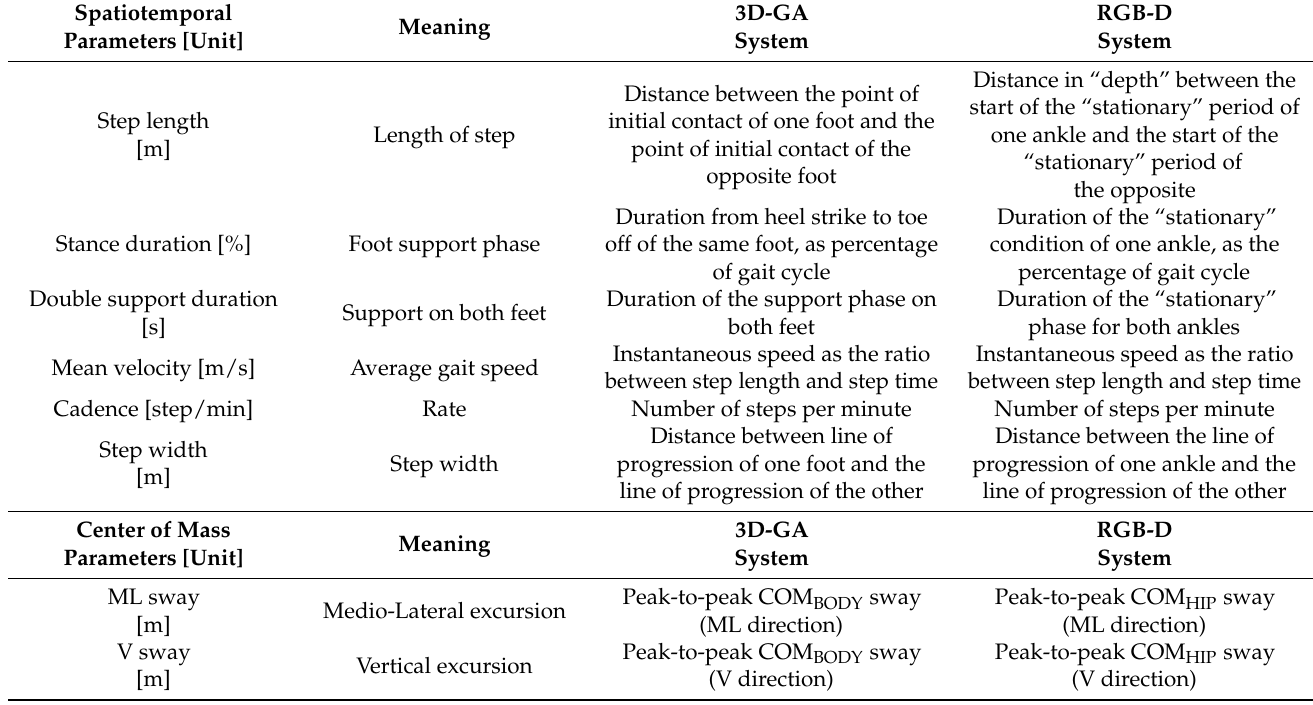
Table 1. Spatiotemporal and COM parameters with meaning and estimation for the 3D-GA and RGB-D systems.